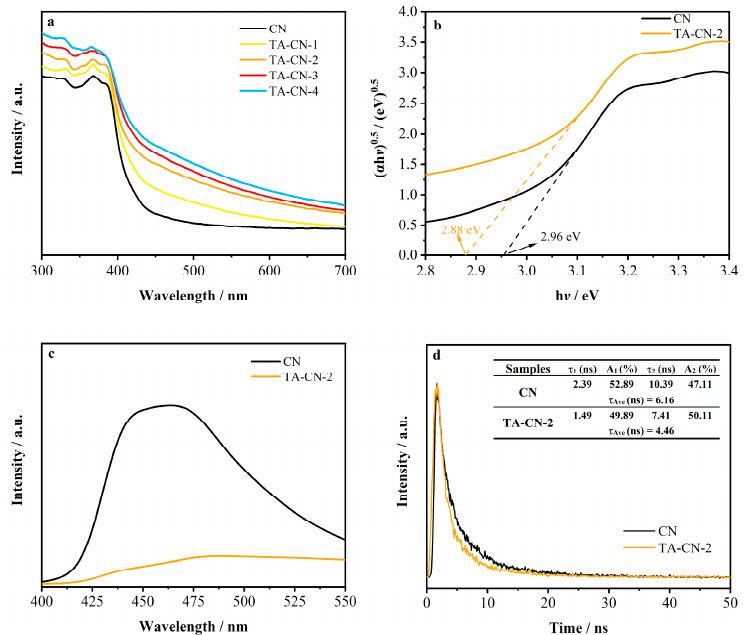
Figure 7. ( a ) UV-Vis diffuse reflection spectra of CN and TA-CN-x; ( b ) Tauc plots; ( c ) PL spectra and ( d ) TR-PL spectra of CN and TA-CN-2 (Inset: Double-exponential fitted lifetimes for CN and TA- CN-2).